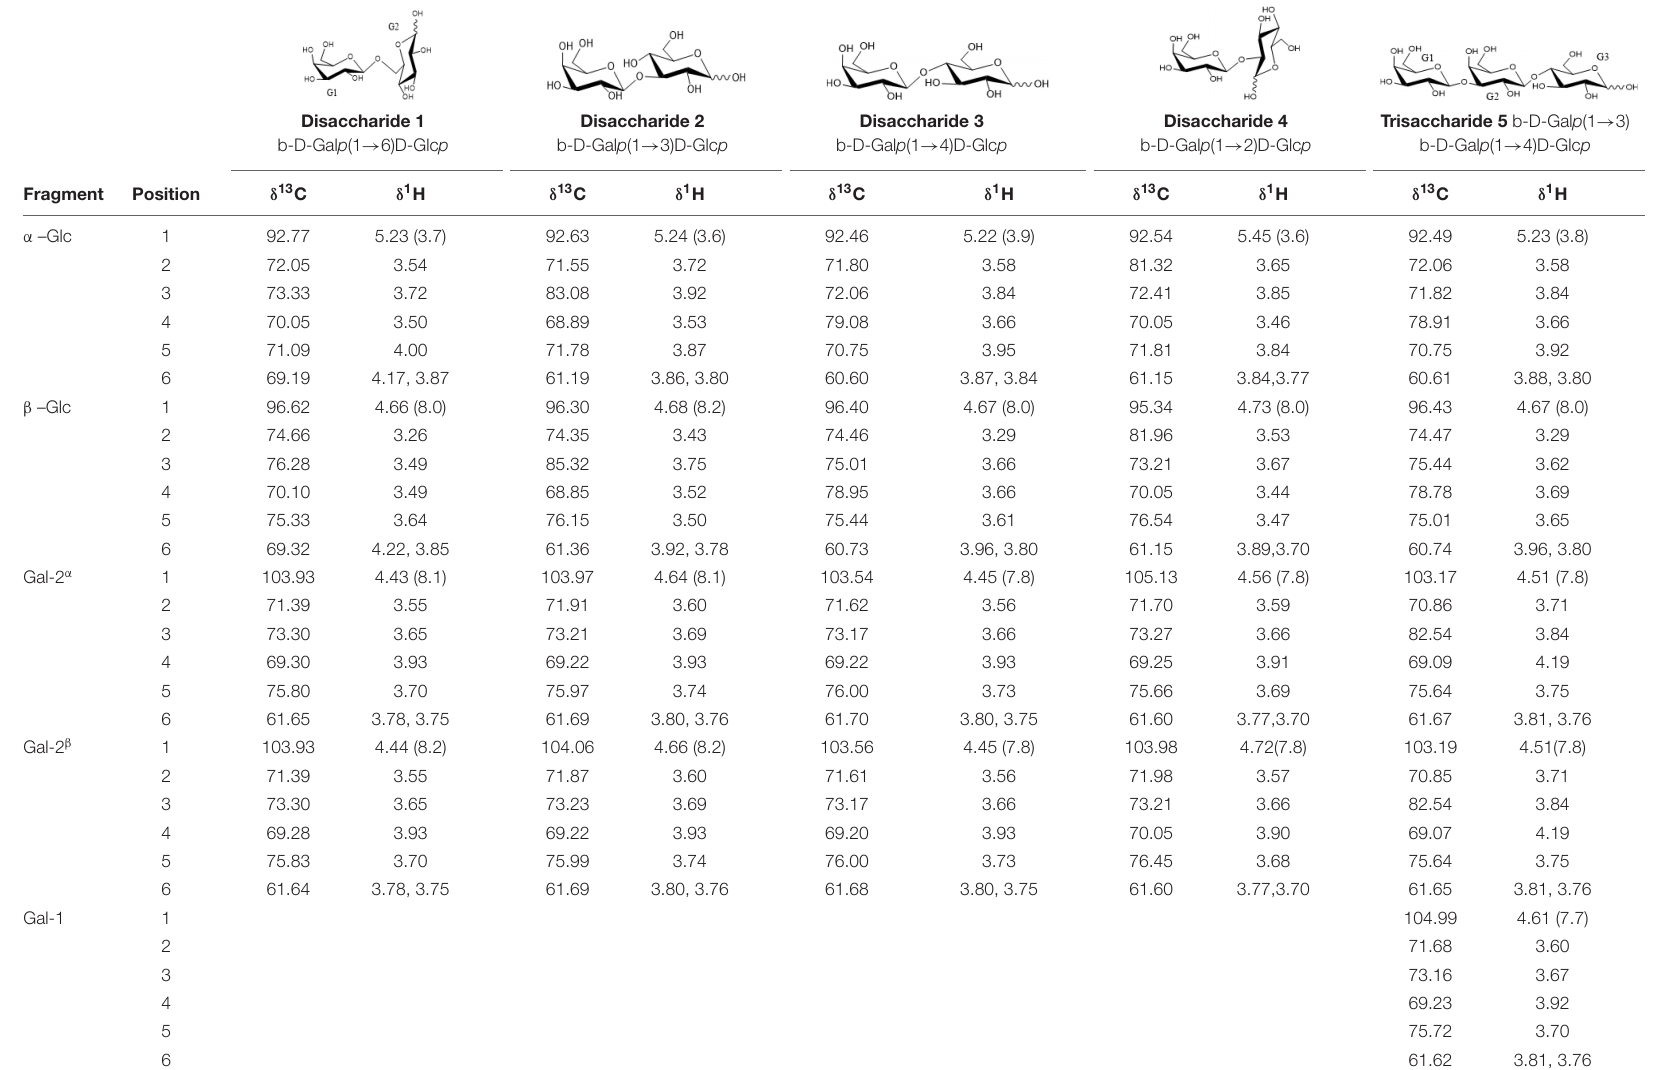
TABLE 4 | 1 H (500 MHz) 13 C(125 MHz) NMR chemical shifts ( δ , ppm) and coupling constants (J in Hz, in parentheses) of compounds 1-5 in GOS-A and